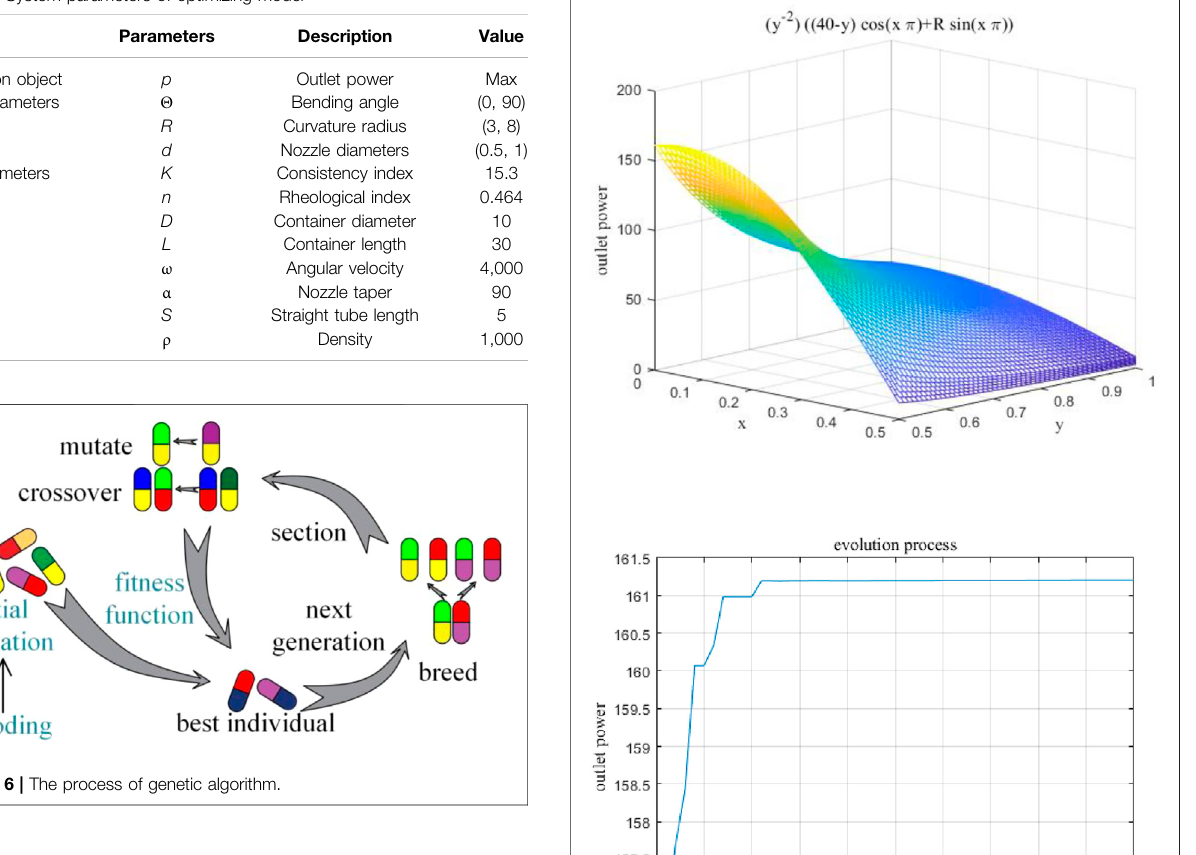
TABLE 3 | System parameters of optimizing model